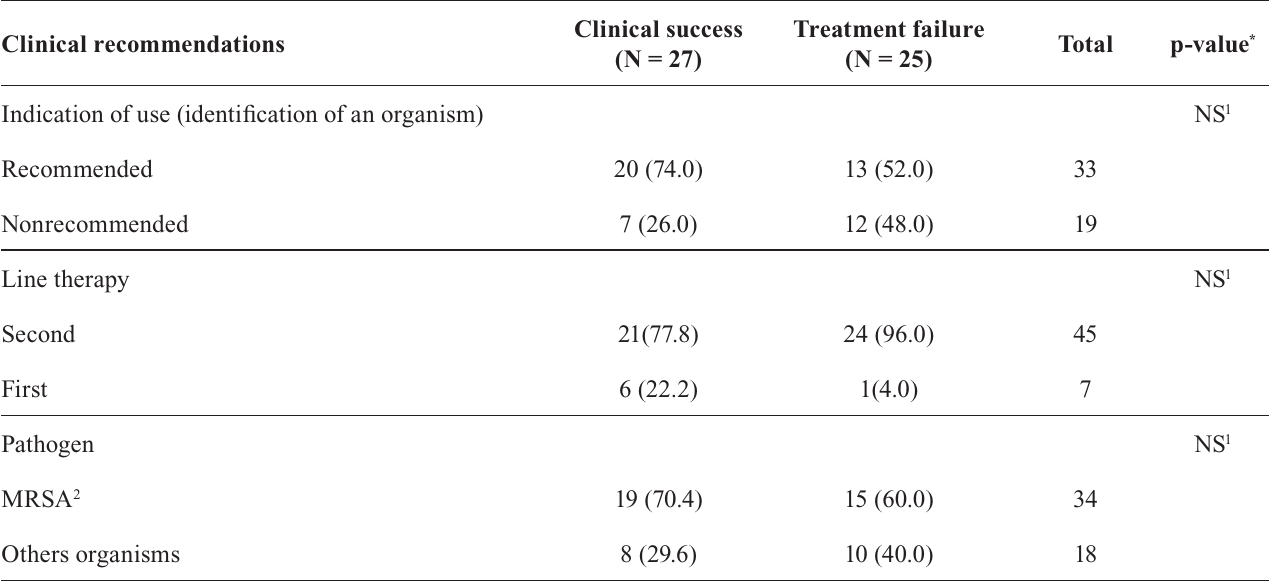
TABLE II - Adherence to different aspects of the clinical recommendations for daptomycin use and clinical success or failure among the 52 patients. Brazil,